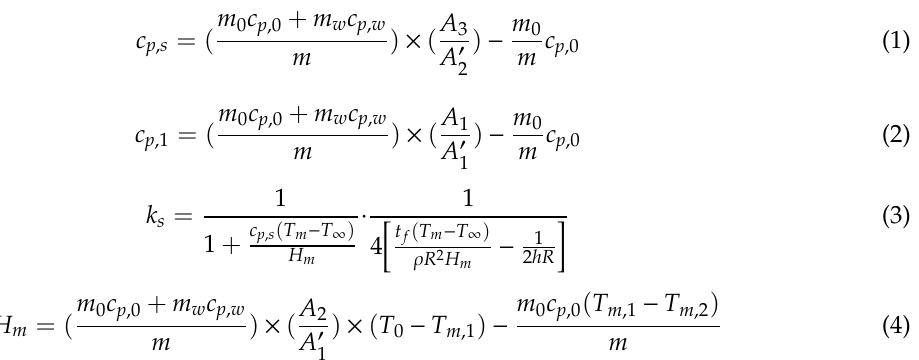
( c ) Figure 3. Photographs of CPCM with ( a ) EG, ( b ) GR, and ( c ) GO. 2.2. Test System of Heat Transfer Performance The experimental unit used in this paper is shown in Figure 4. The heat transfer performance